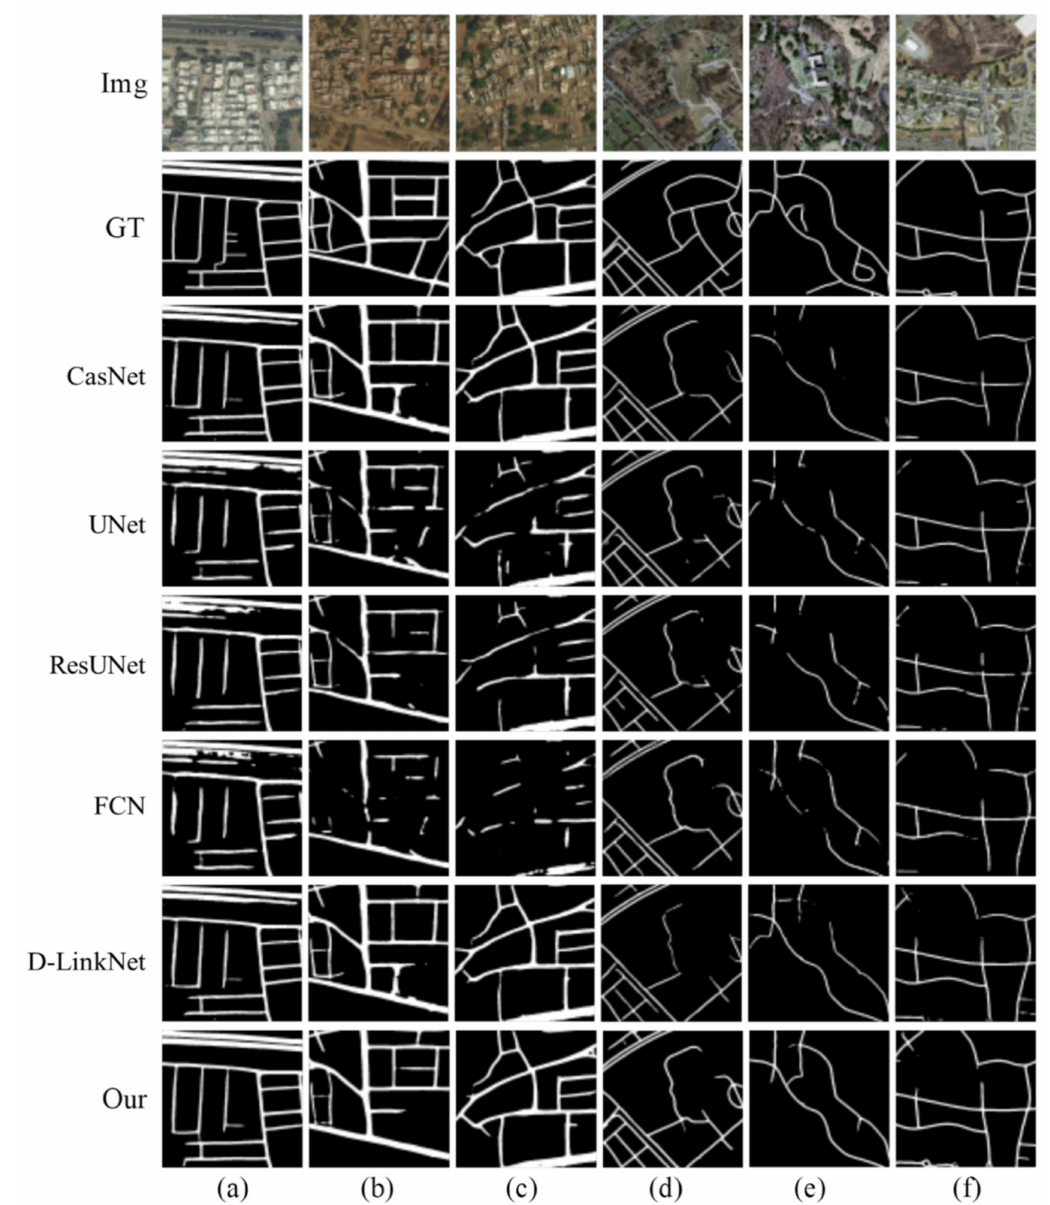
Figure 4. Examples of road extraction obtained by the compared methods. ( a – c ) Selected from the DeepGlobe dataset, and ( d – f ) showed on the Massachusetts